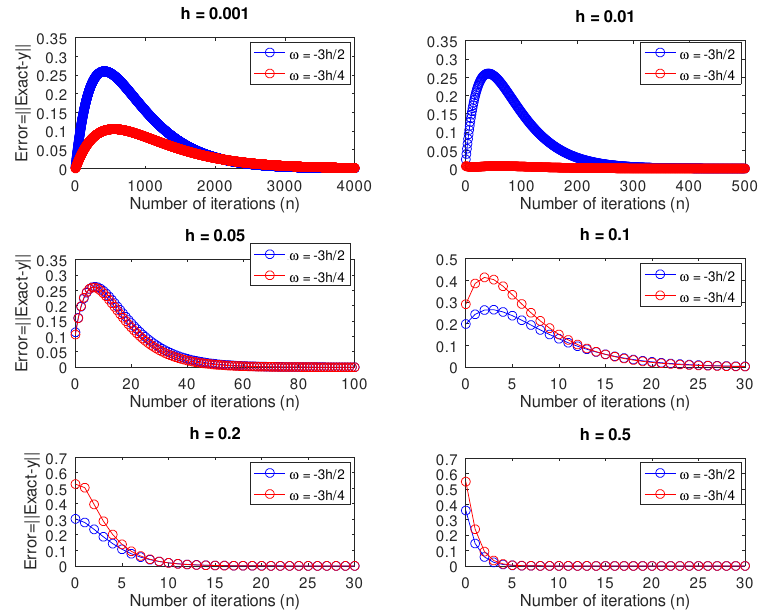
Figure 5. Comparing the norm of the difference between the exact solution and the vector [ y n + 1 , y n + 2 ] T for different values of step sizes using the discrete schemes (11) corresponding to 3 h ω = and the discrete schemes (12) corresponding to ω = 4 − system of linear equations.